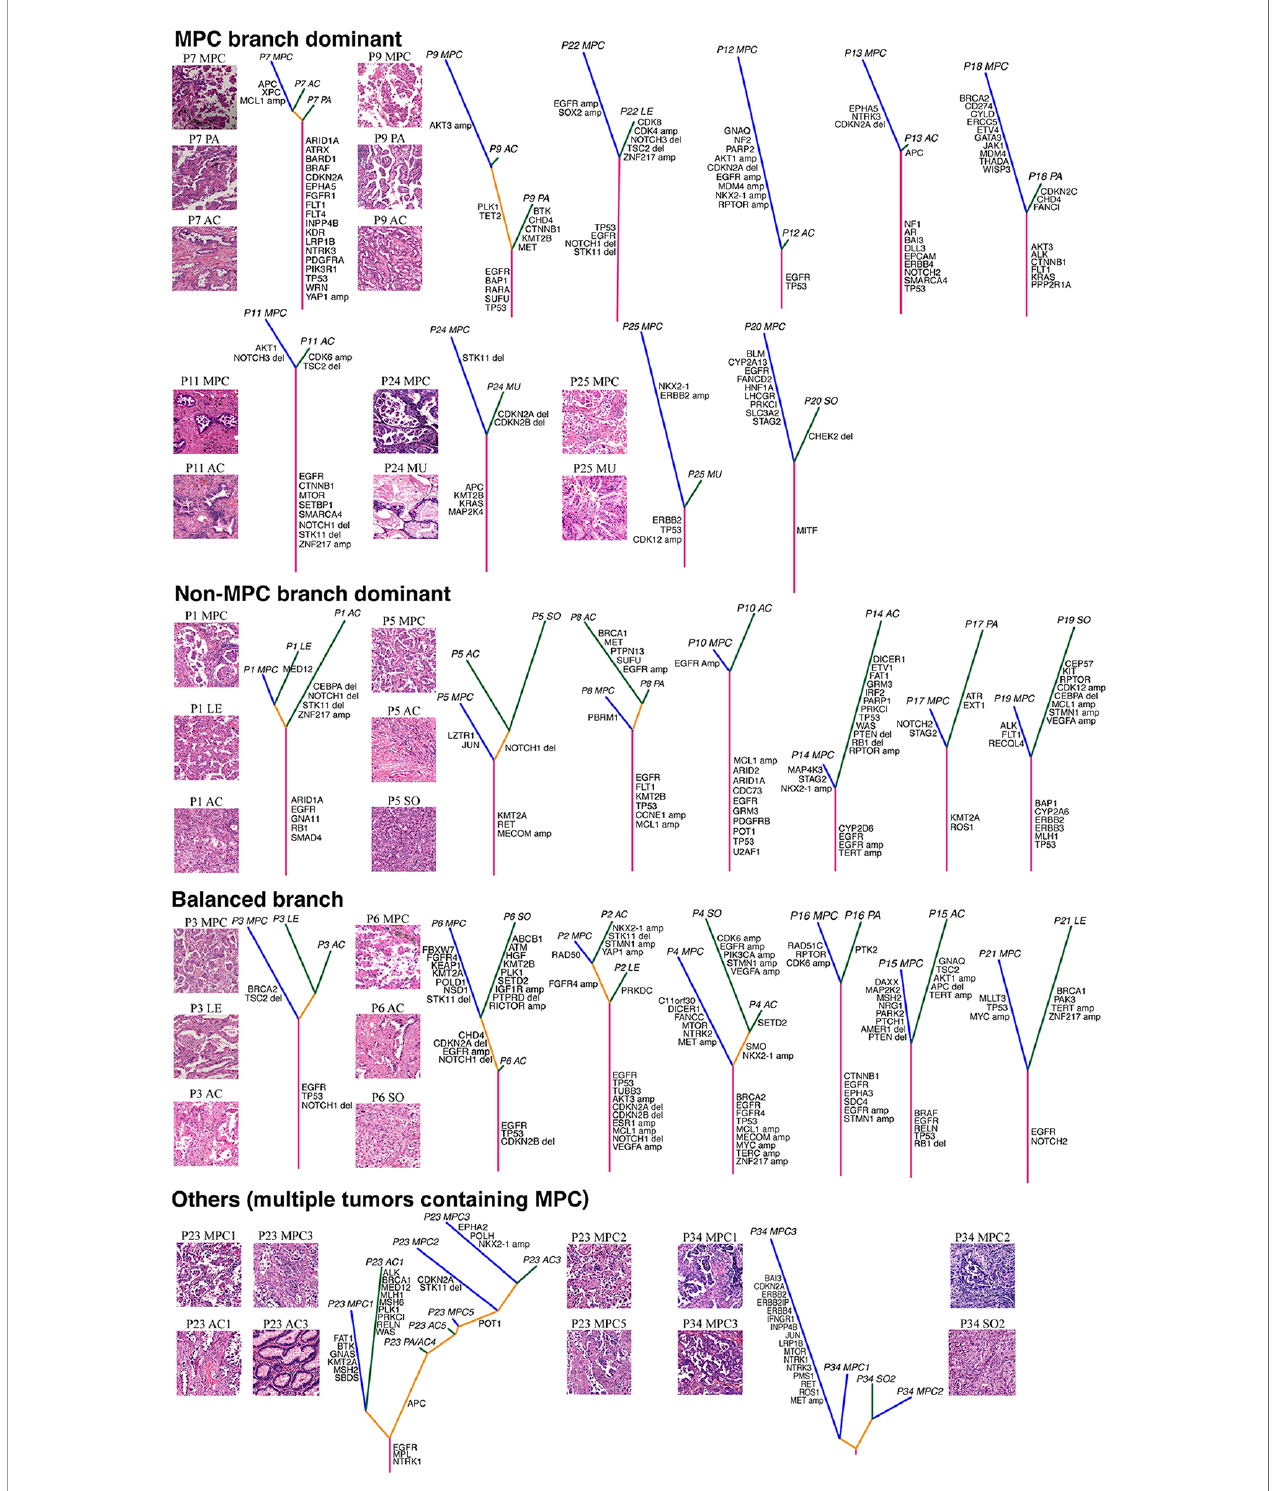
FIGURE 2 | The molecular phylogenetic tree for each patient within the discovery cohort. The length of the stem and the branch represents the number of genetic alterations, including mutations, gene-level copy number variations (CNVs), and arm-level CNVs. Representative hematoxylin and eosin (H&E) staining of different histologic subtypes were illustrated. The mutations and gene-level CNVs were labelled on the branch of the phylogenetic tree. AC, acinar; LE, lepidic; MPC, micropapillary; MU, mucinous; PA, papillary; PA_AC, acinar and papillary mixture; SO, solid.